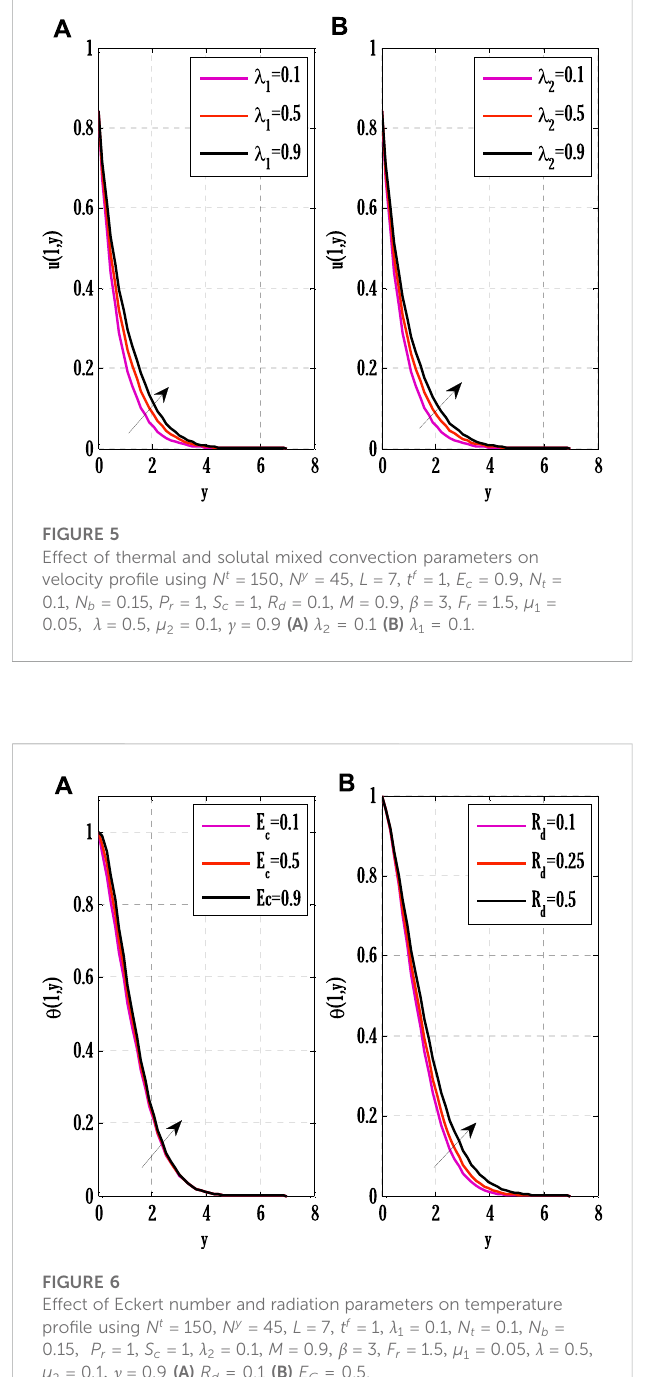
FIGURE 6 Effect of Eckert number and radiation parameters on temperature pro fi le using N t (cid:2) 150 , N y (cid:2) 45 , L (cid:2) 7 , t f (cid:2) 1 , λ 1 (cid:2) 0 . 1 , N t (cid:2) 0 . 1 , N b (cid:2) 0 . 15 , P r (cid:2) 1 , S c (cid:2) 1 , λ 2 (cid:2) 0 . 1 , M (cid:2) 0 . 9 , β (cid:2) 3 , F r (cid:2) 1 . 5 , μ 1 (cid:2) 0 . 05 , λ (cid:2) 0 . 5 , μ (cid:2) 0 . 1 , γ (cid:2) 0 . 9 (A) R d = 0.1 (B) E C = 0.5. 2